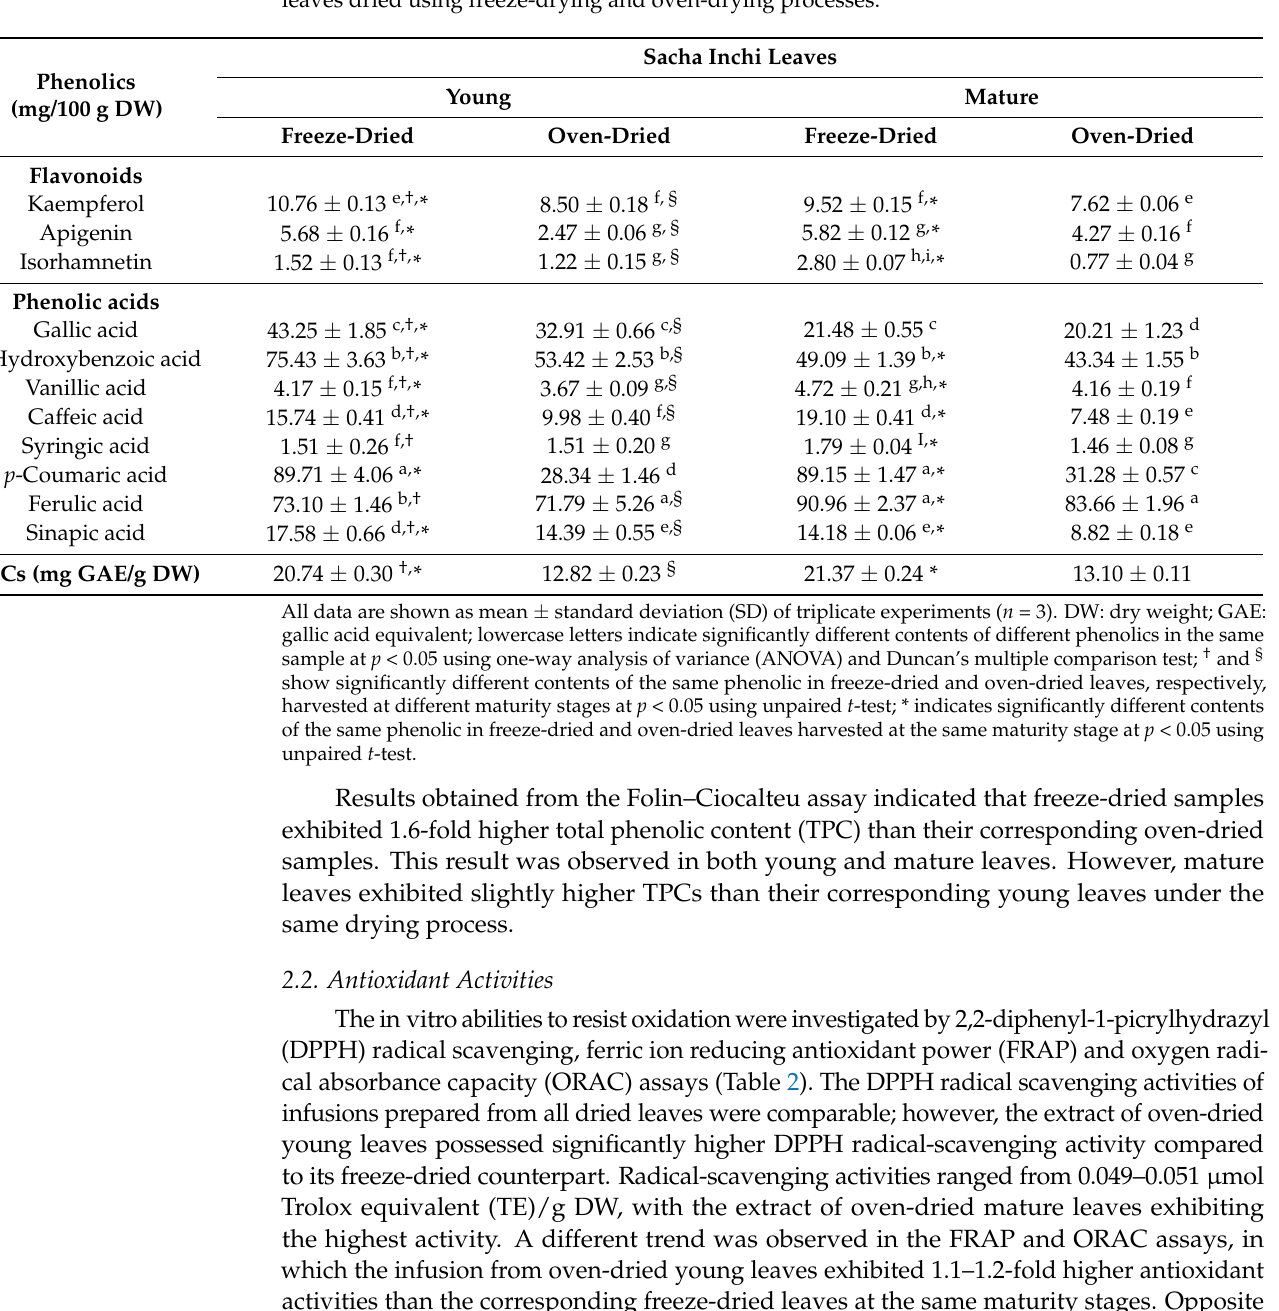
Table 1. Phenolic compositions and total phenolic contents (TPCs) in young and mature sacha inchi leaves dried using freeze-drying and oven-drying